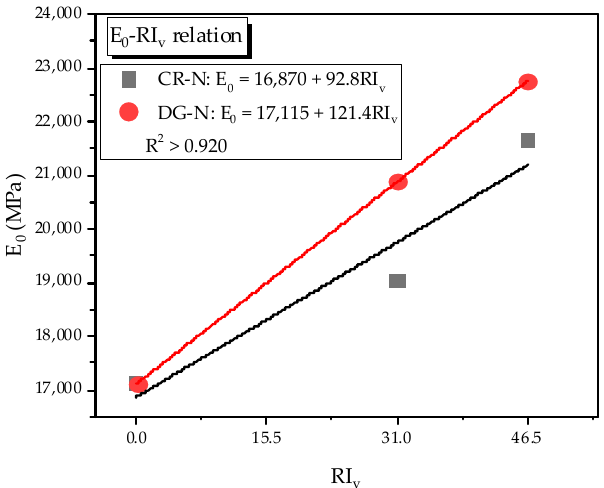
Figure 14. Relation of the reinforcing index and elastic modulus.